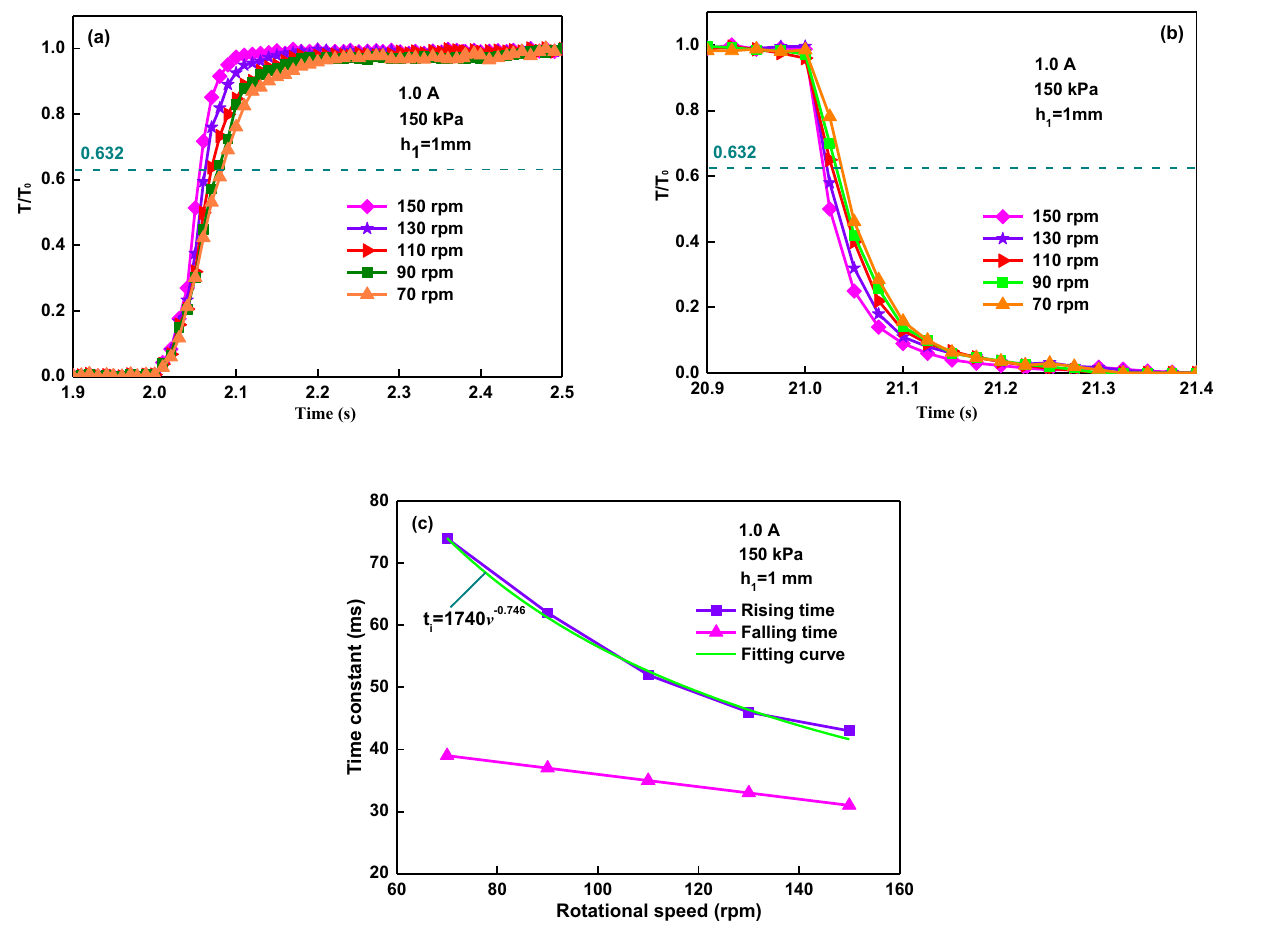
Figure 6. Torque response affected by rotational speed: ( a ) normalized torque versus rising time; ( b ) normalized torque versus falling time; ( c ) time constant versus rotational